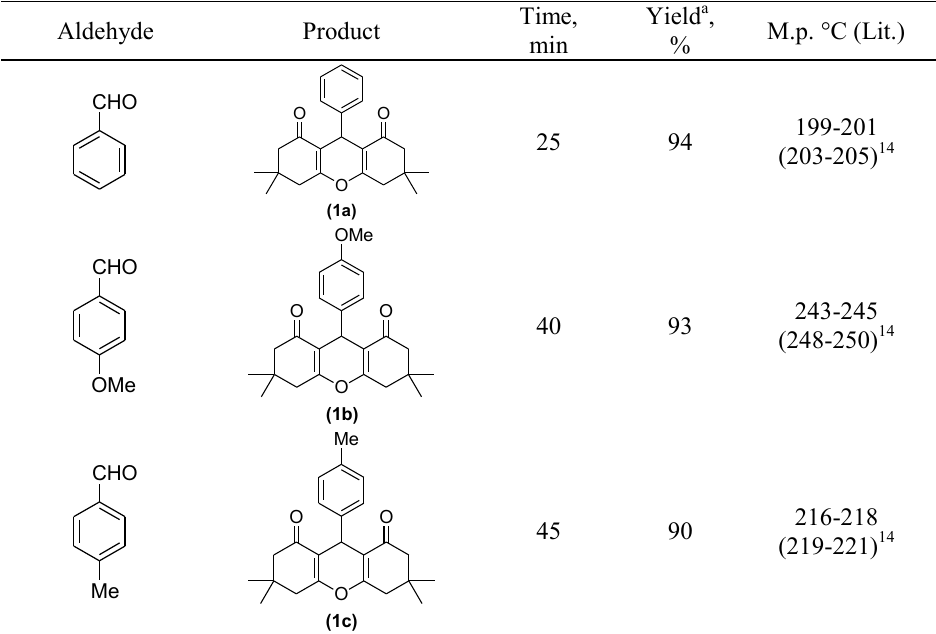
Table 2. The synthesis of 1,8-dioxo-octahydroxanthenes from dimedone and aromatic aldehyde using